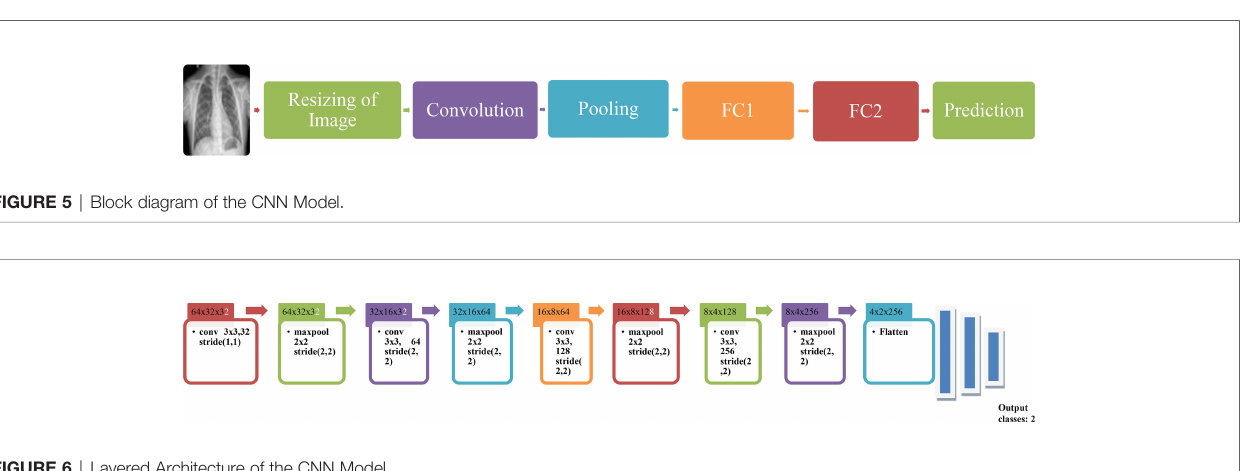
FIGURE 6 | Layered Architecture of the